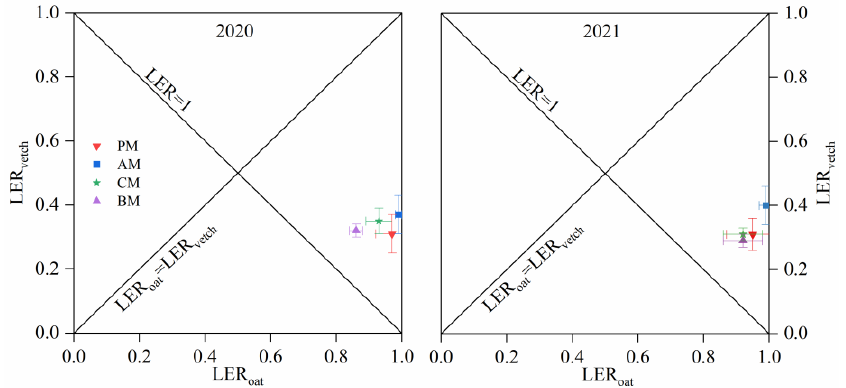
Figure 5. Partial LER values among different cropping systems over two years in Yanchi county, Ningxia, China. Areas corresponding to values above 0.5 for common vetch and for forage oat represent situations where species yield is higher when mixture cropping. The bottom right quadrant area corresponds to situations in which forage oat suppress common vetch; the reverse is true in the left upper quadrant area.